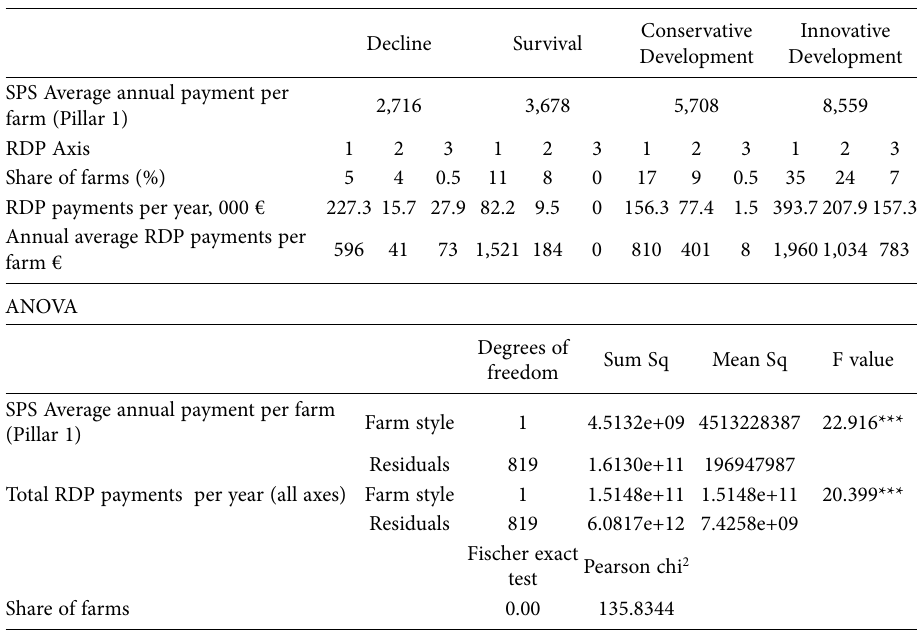
Source: own elaboration on ARTEA data (2007-2012) and census data (2010). ( *** significance at 0.01; ** significance at 0.05, * significance at